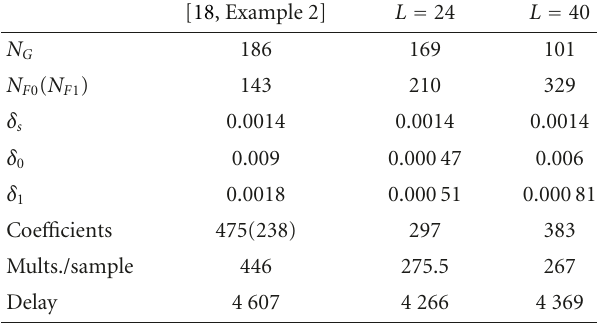
Table 2: Comparison with [18, Example